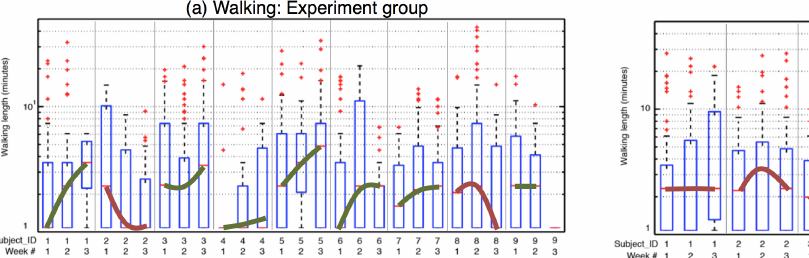
Figure 5. Box plots showing the distribution of walking lengths for the experimental group (a) and for the control group (b) over the 3-week study. We joined the medians of distributions and showed each trend as a thick green line (increasing trend) or red line (decreasing trend) for walking